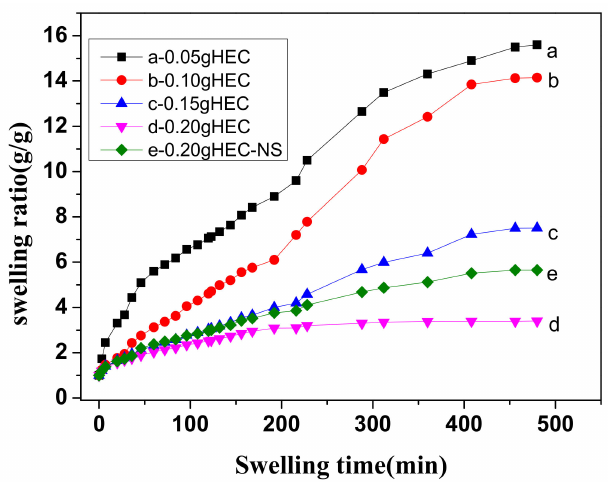
Figure 9. Swelling rate of the di ff erent hydrogels ( a ) Gel-1 in DI water; ( b ) Gel-2 in DI water; ( c ) Gel-3 in DI water; ( d ) Gel-4 in DI water and ( e ) Gel-4 in salt